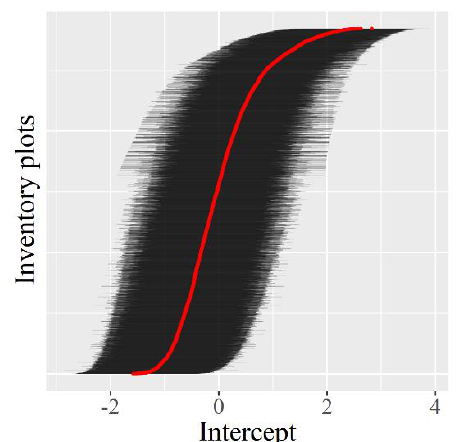
Figure A3. Random effects (red dots) with a variance of 0.97 and error bars (black horizontal lines) of the inventory plots within the generalized linear mixed model (GLMM). The individual inventory plots—sorted from the highest positive to the lowest negative shift—are shown on the y-axis.